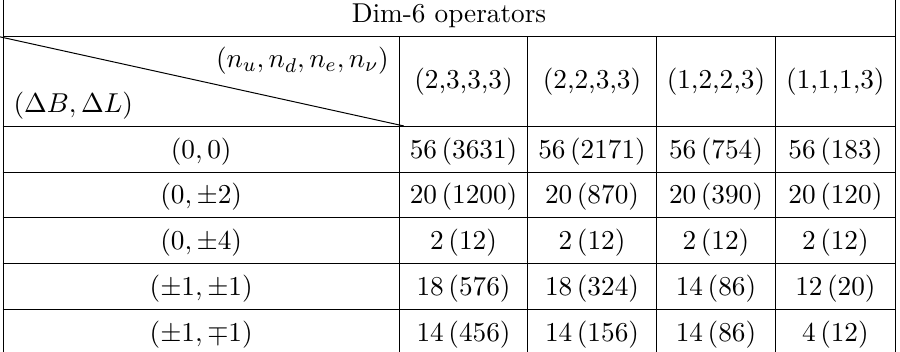
Table 5 . The number of types (operators) of each baryon-number and lepton-number violation pattern with various flavor numbers at dimension 6. n of up-type quarks, down-type quarks, charged leptons and neutrinos respectively. For n n u = 1 , the corresponding active up-type quarks are ( c, u ) and ( u ) respectively, For n d = 3 , 2 , 1 , active down-type quarks are ( b, s, d ) , ( s, d ) and ( d ) respectively, n charged letpons ( τ, µ, e ) , ( µ, e ) and ( e )